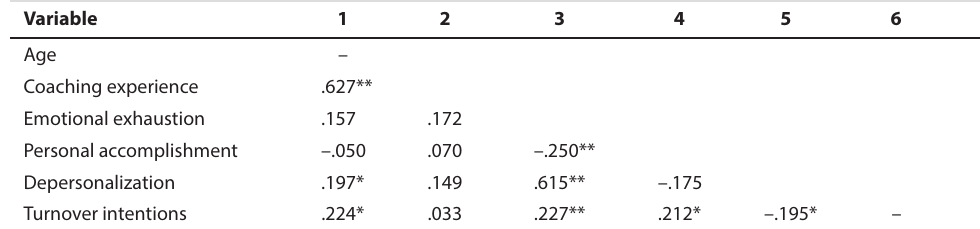
TABLE 3 Correlations Between Demographic Variables, Burnout Subscales and Turnover Intention